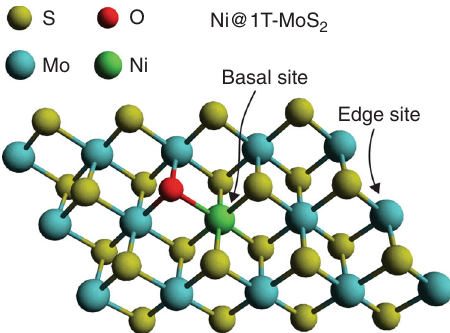
Fig. 1 Ni@1T-MoS 2 structure. Segment of 1T-MoS 2 structure with basal plane dopant NiO moiety shown in the